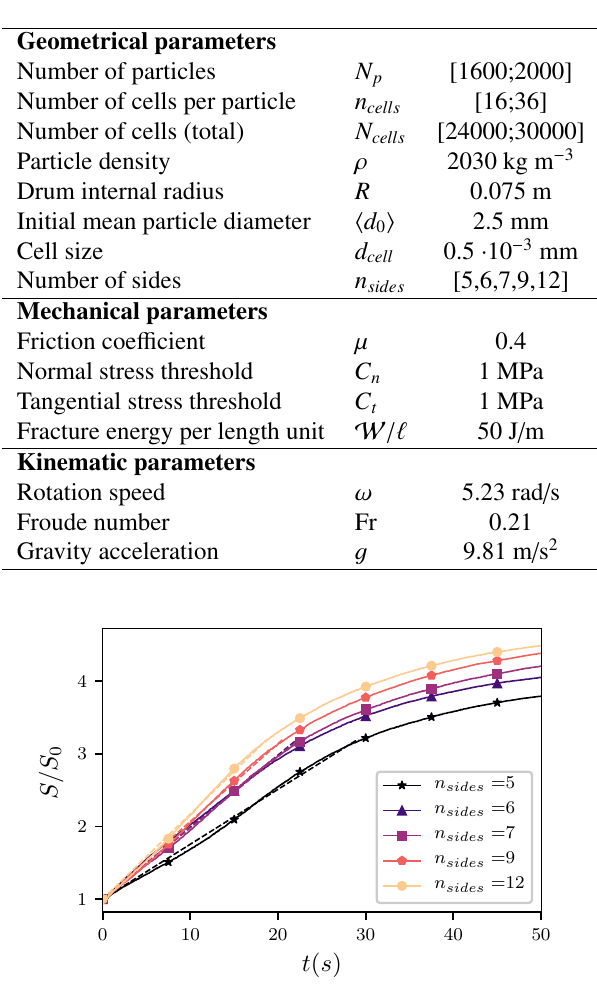
Table 1. Simulation parameters